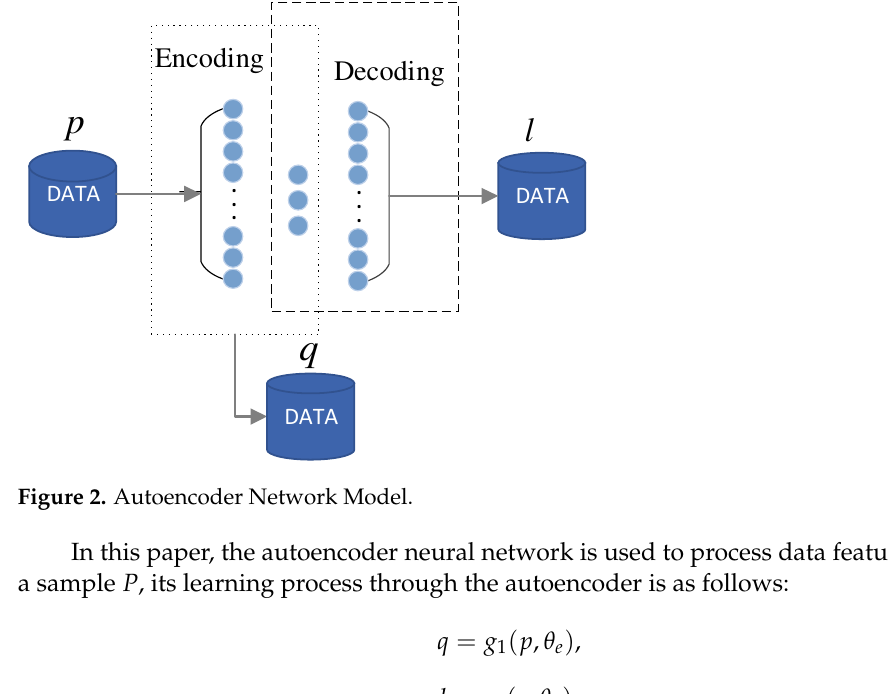
Figure 2. The autoencoder compresses the original data features by the encoder to get new features and then reconstructs the original data by the decoder.